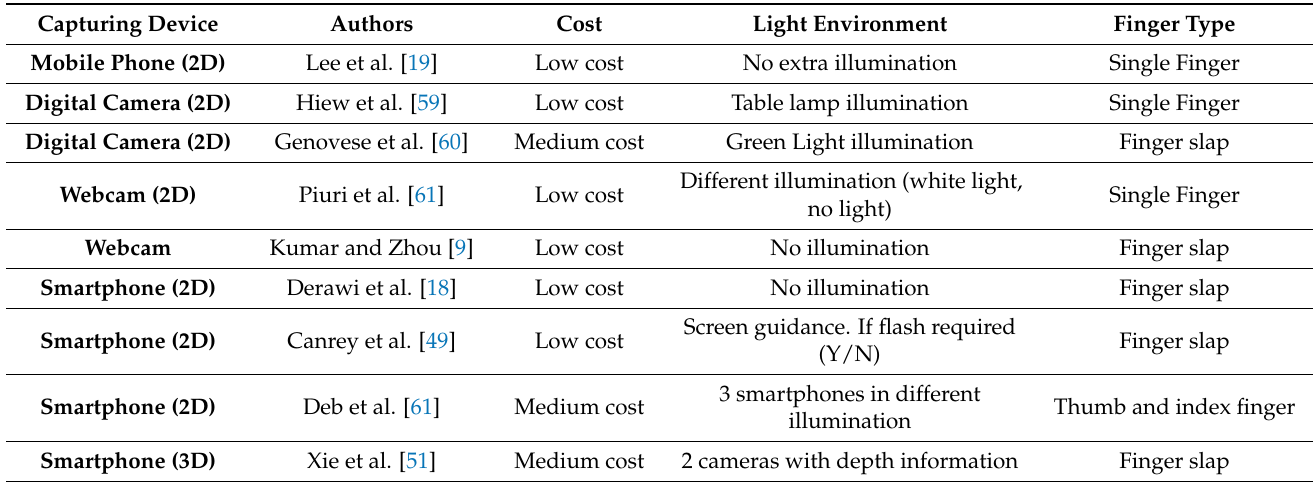
Table 2. Overview of contactless 2D and 3D capturing devices and their properties.